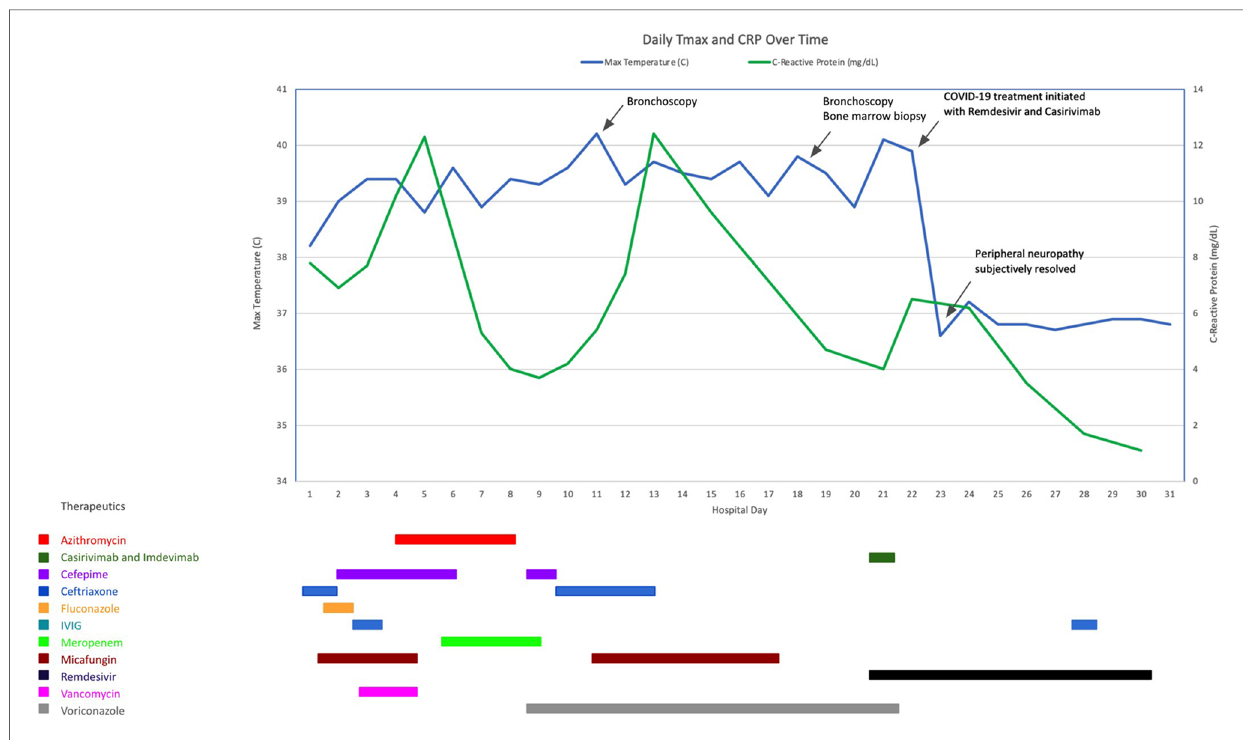
FIGURE 2 Clinical course and treatment of the patient including daily maximum temperature (Tmax) and C-reactive protein (CRP) during his